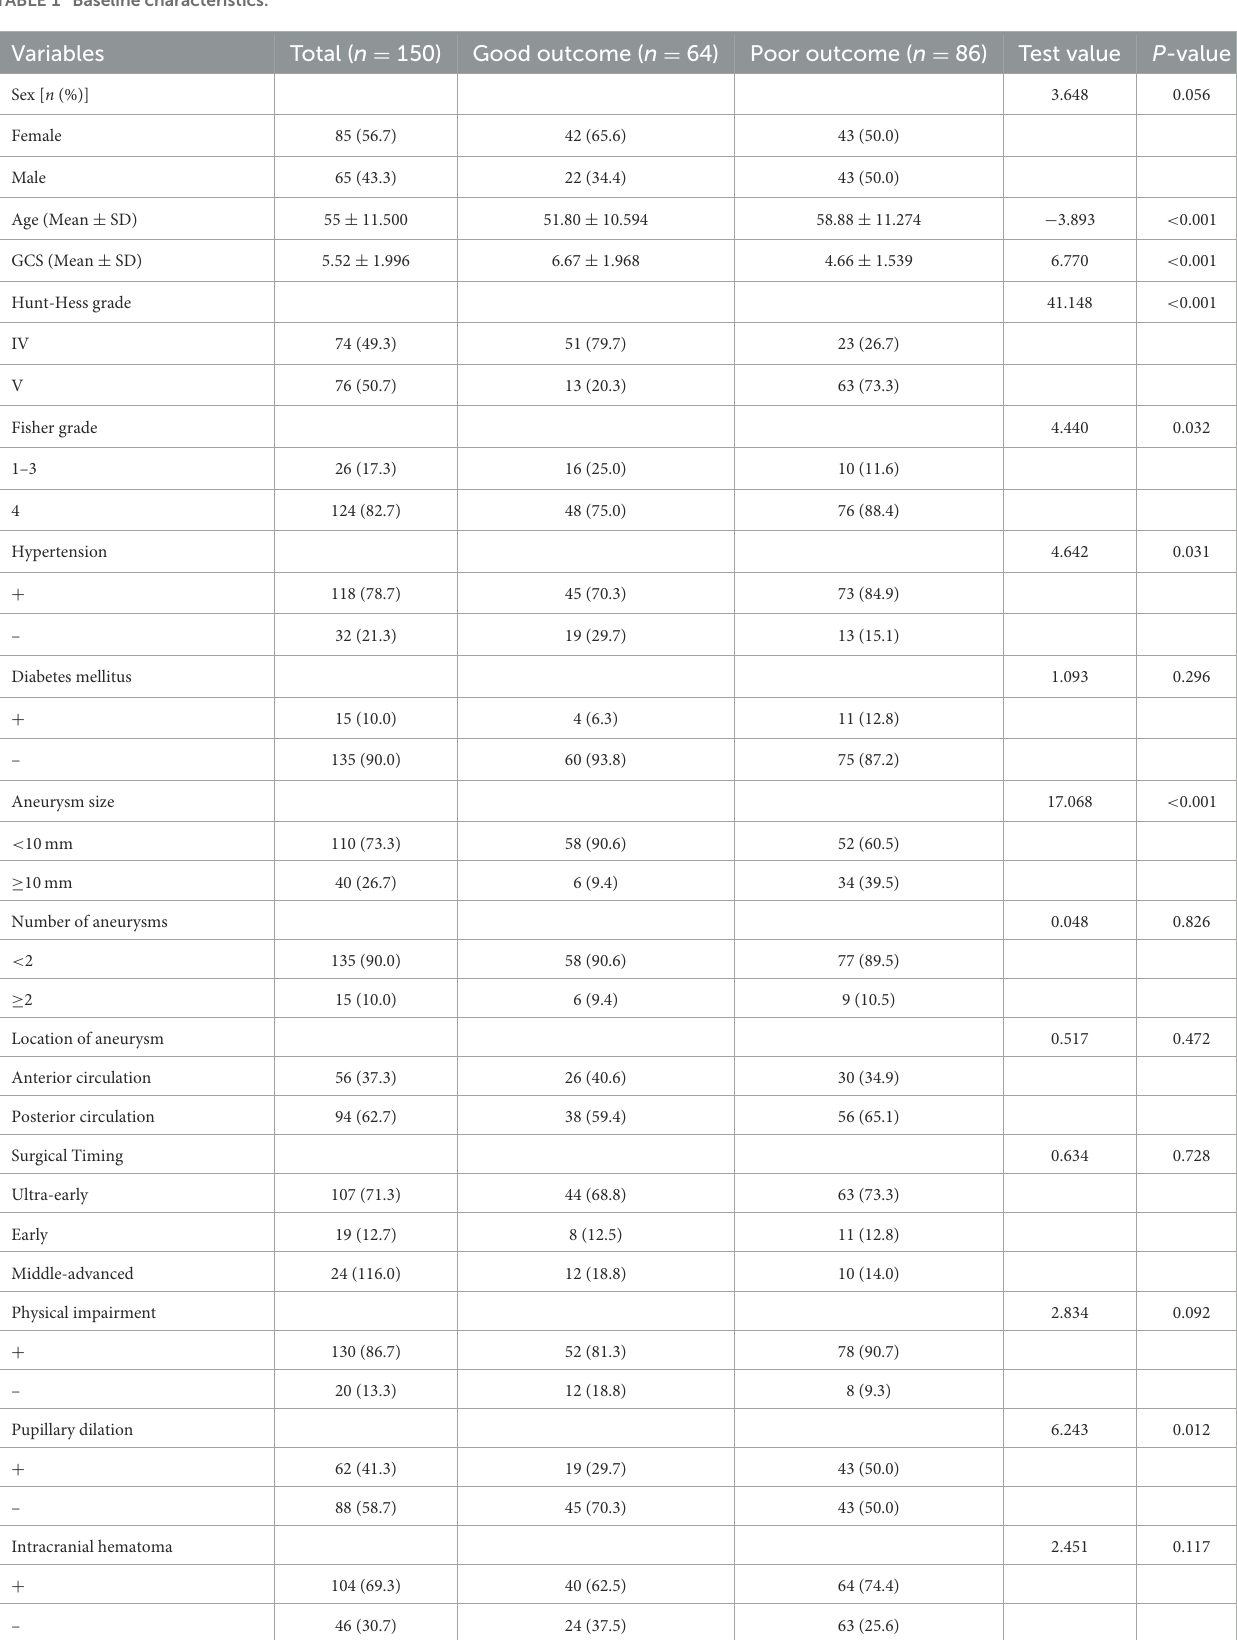
TABLE 1 Baseline